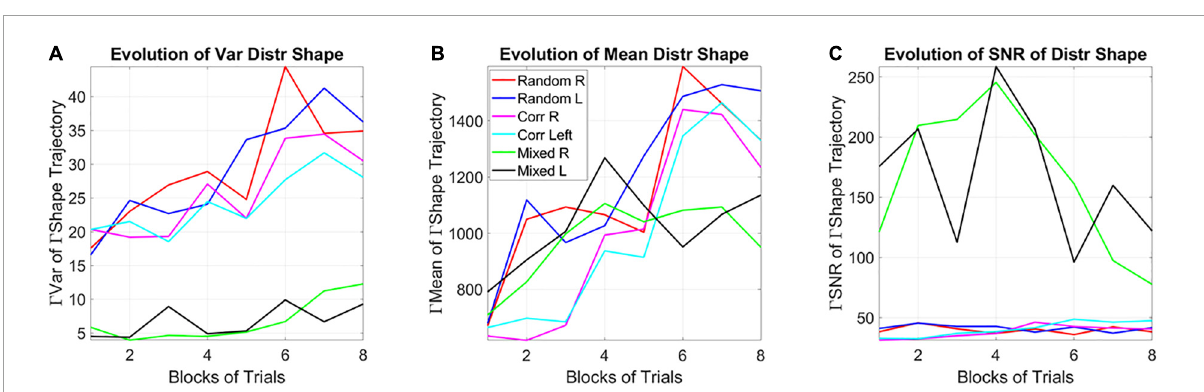
FIGURE8 Learning evolution taken globally across participants and full session, shows the unstable environment (mixed group) to provide the most efficient conditions for learning, as indicated by the highest SNR. (A) Tracking, block by block, the empirically estimated variance of the distribution of gamma shape values obtained from the fluctuations in MMS amplitudes for each type of stimulus and target. Correlated and random groups trend upward with a steeper rate for correlated, while the mixed group stabilizes after 1 / 2 the session. The variance separates the correlated and random groups from the mixed group, with a marked reduction on the variability of distribution shapes and an overall trend to increase the variability in distribution shape toward the final blocks. (B) Tracking, block by block, the empirically estimated mean value of the distribution of shape values from the fluctuations in MMS amplitudes. (C) The signal to noise ratio (mean/variance) then shows the highest signal for the mixed trials, with a downward tendency after 1 / 2 the total session.